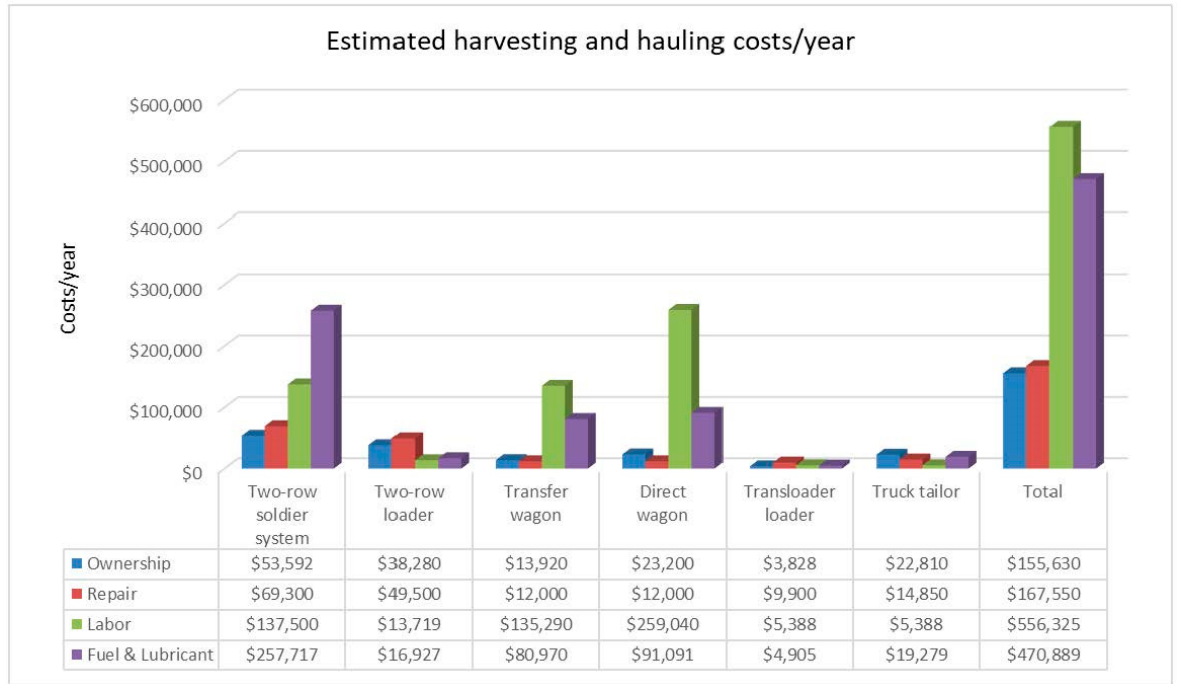
Figure 2. Summary of costs to operate a harvesting and hauling unit/year of energycane.